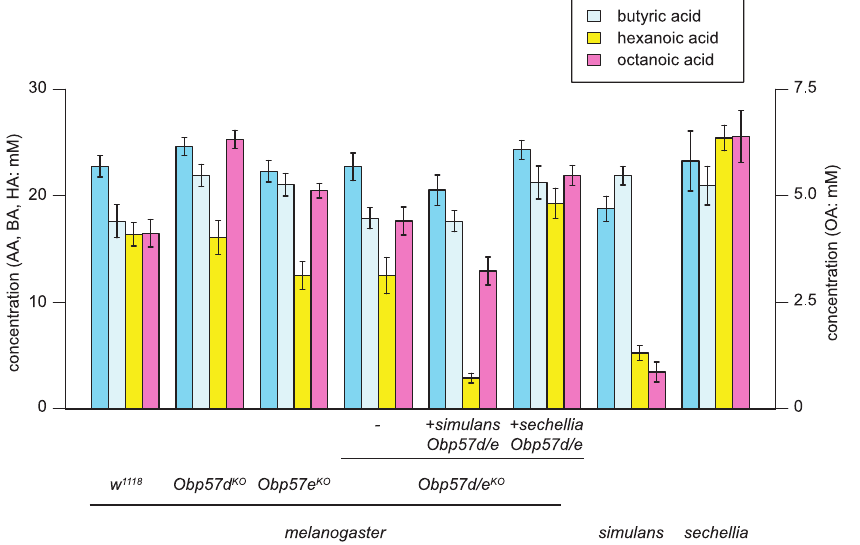
Figure 6. Preferred Concentration of Acids in Oviposition Site–Preference Assay Staged females were individually provided with four types of medium containing each acid at different concentrations. The concentrations were 0 mM, 10 mM, 20 mM, and 30 mM for acetic acid (AA), butyric acid (BA), and hexanoic acid (HA), and 0 mM, 2.5 mM, 5 mM, and 7.5 mM for octanoic acid (OA). The number of eggs laid on each medium was scored, and the weighted mean of acid concentration was calculated individually. Each bar represents a mean of 36 individuals from three replications. Error bars indicate standard error.